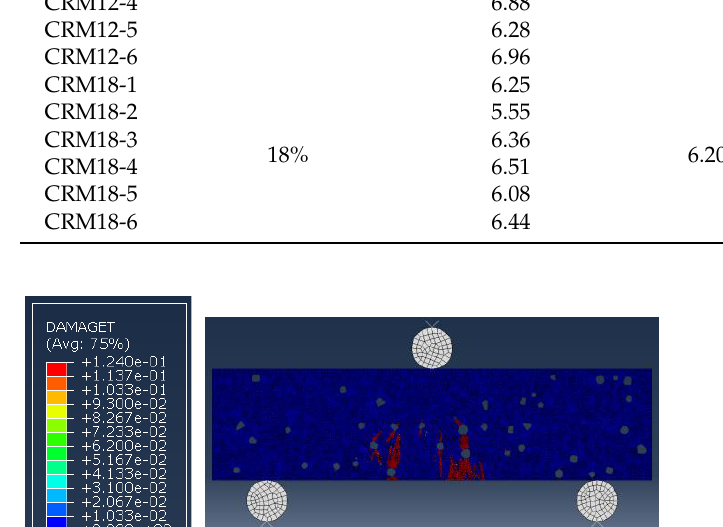
Figure 25. Tensile damage of CRM 12 specimens. Figure 23. Rubber particles in a 2D CRM6 sample.